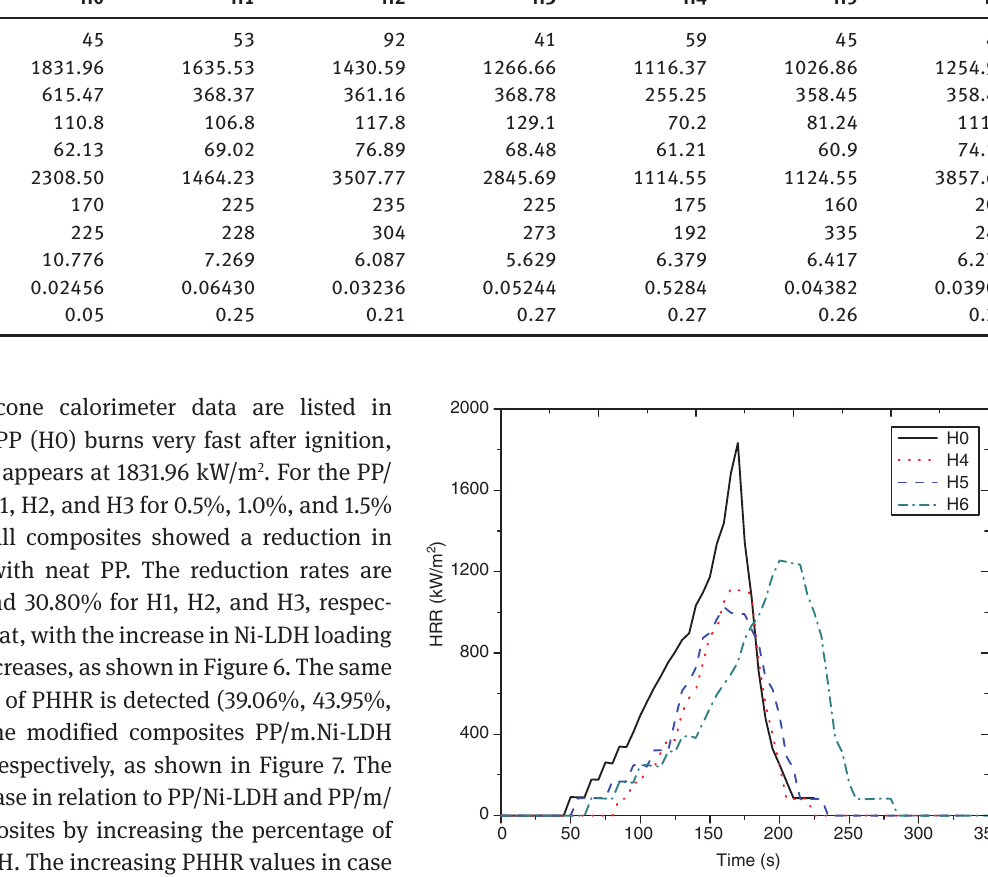
Table 4: Cone calorimetric data for the PP/Ni-LDH and PP/m.NiLDH nanocomposites. Parameter